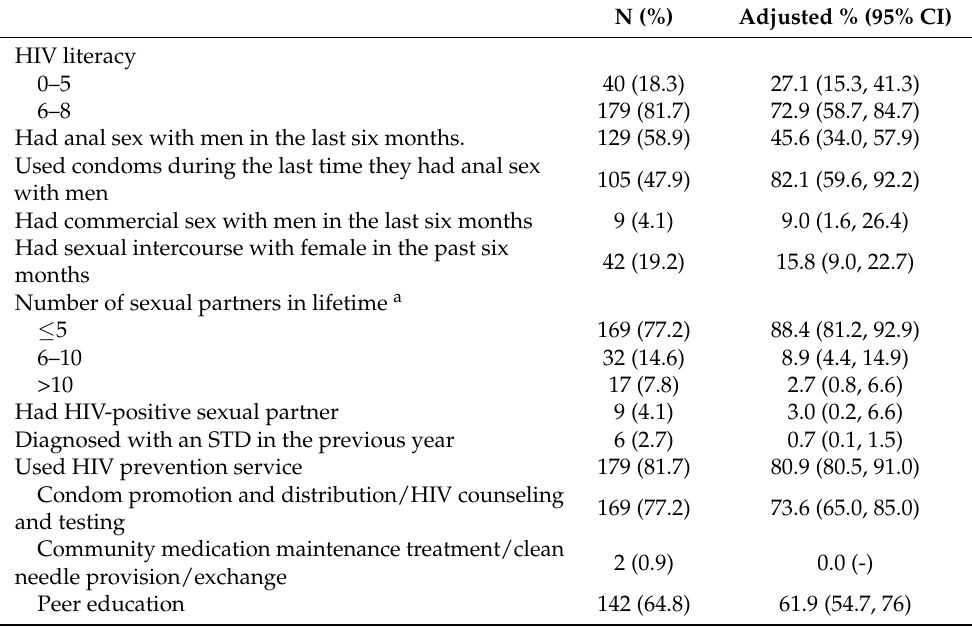
Table 4. Crude and adjusted HIV-related knowledge and behavior among men who have sex with men in Guilin, China ( n =